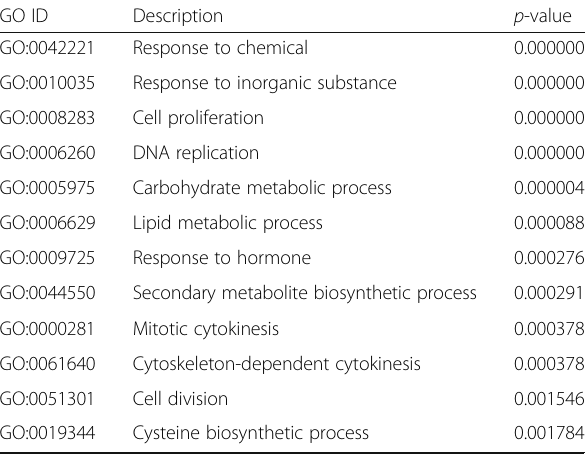
Table 4 Significant GO Terms of DG HP Between CS and YS in the Biological Process Category